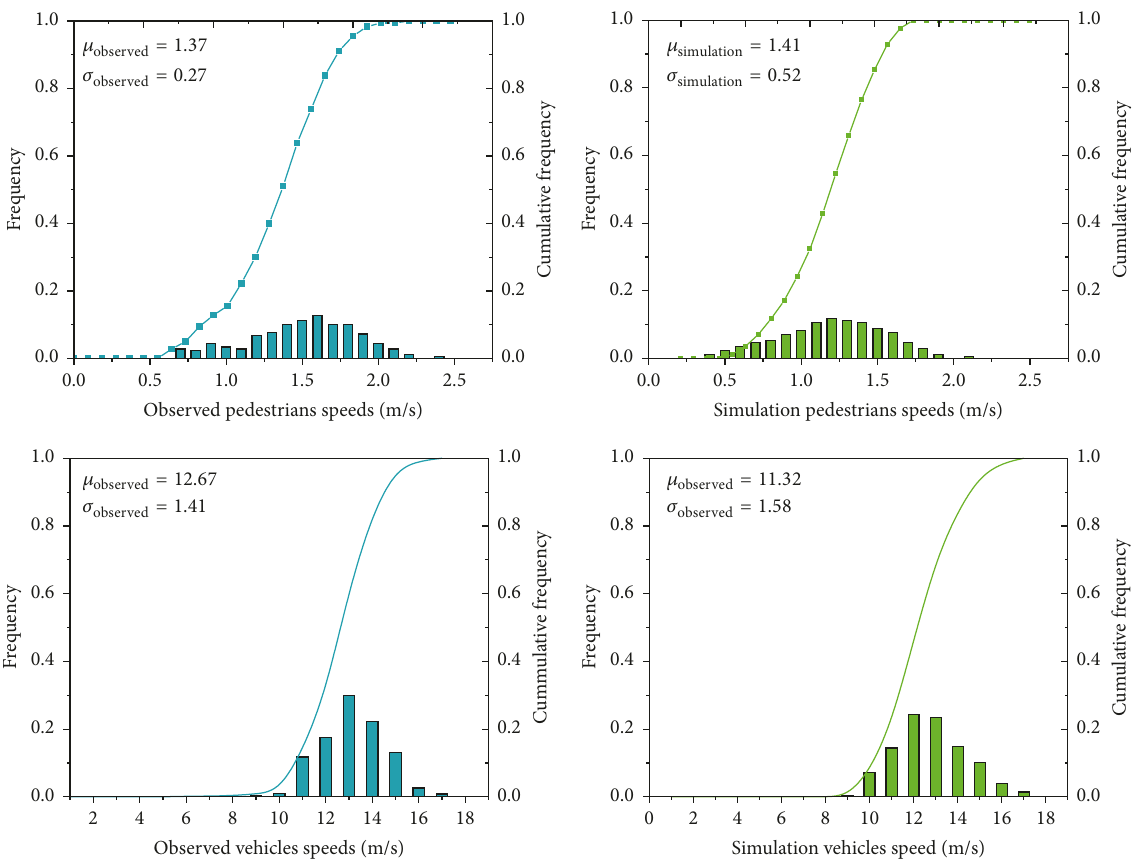
Figure 11: Speed histograms of pedestrians observed and simulation